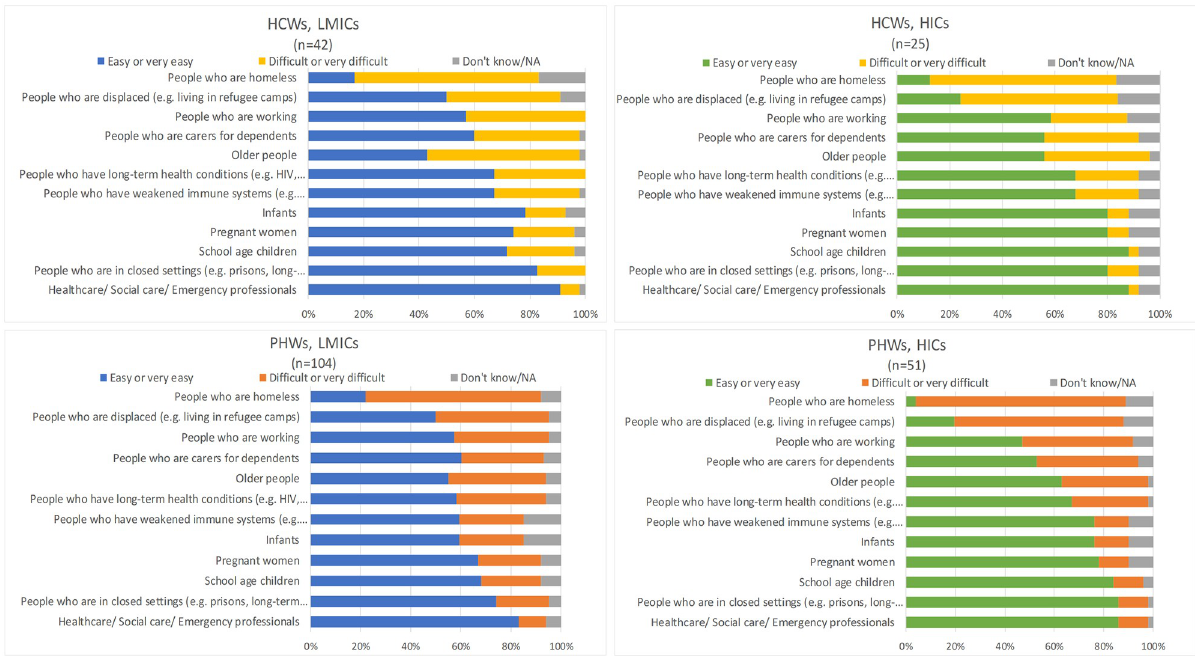
Fig 2. Public health workers’ and healthcare workers’ assessment of the practicality of implementing a COVID-19 vaccine for certain population groups.